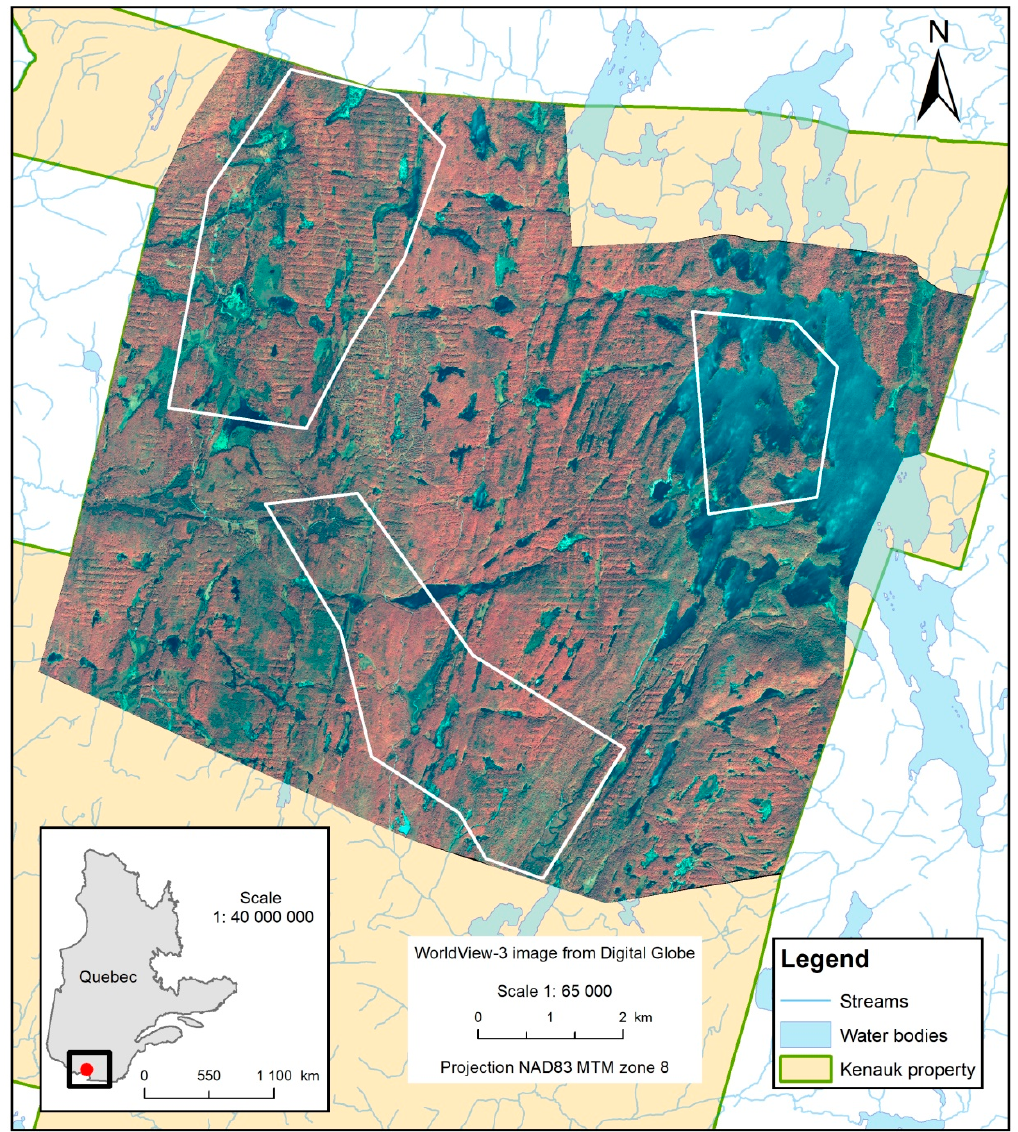
Figure 1. Study areas (delineated in white) at the Kenauk Nature property. The background image displays WorldView-3 in false colors (infrared, green and blue).